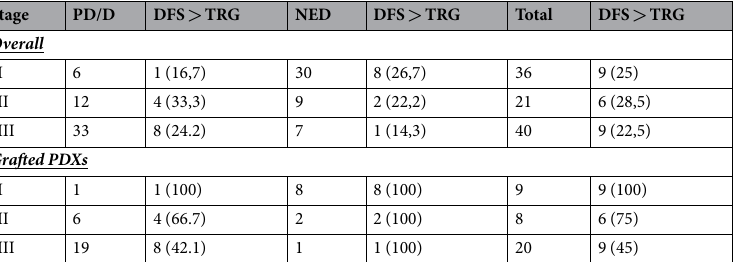
Table 4. PDXs as “Avatars” (DFS > TRG) in relation to patients follow-up. PD: Progression of Disease; D: Death; NED: No Evidence of Disease; DFS: Disease Free Survival; TRG: Time to reach